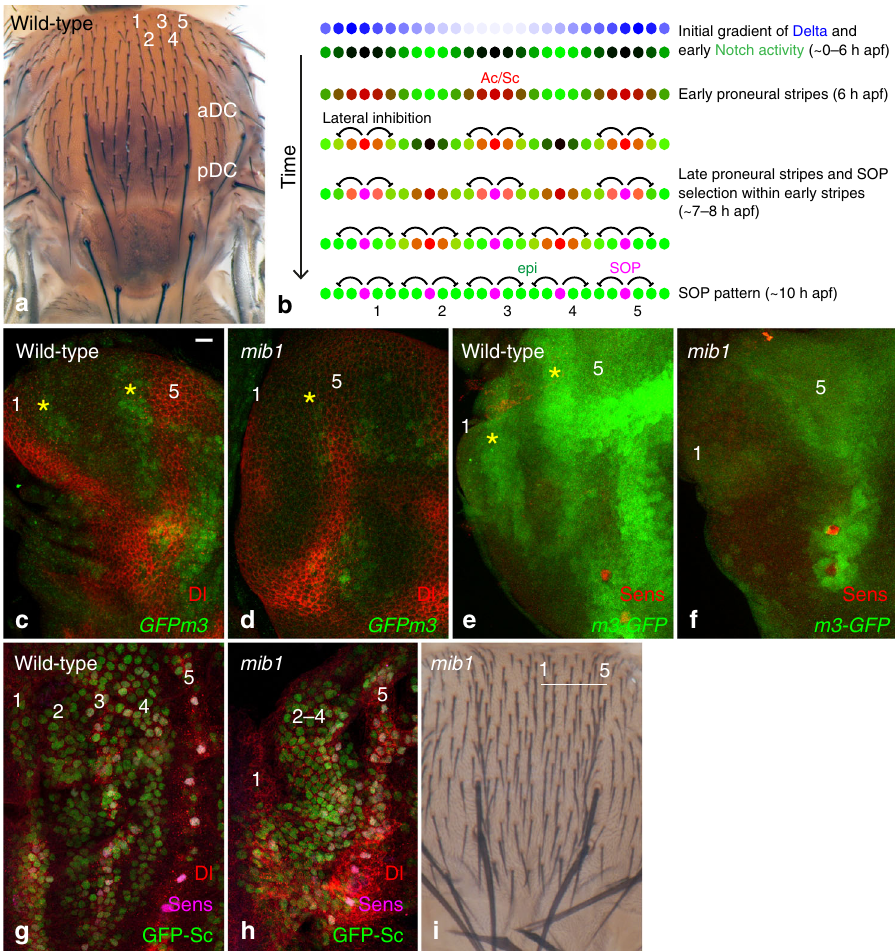
Fig. 1 mib1 -dependent Notch activity is required for stripe patterning. a A dorsal view of a wild-type adult fl y showing the fi ve regular rows of microchaetae (1 – 5) on each hemi-notum. The anterior and posterior DC macrochaetae (aDC and pDC) are located at the base of row 5. b Patterning dynamics in the notum 9 : downstream of a bimodal gradient of Dl, a proneural-independent pattern of Notch activity (green) determines the position of the fi rst proneural stripes (proneural activity, red). As the pattern of Notch activity evolves, two additional proneural stripes emerge and SOPs (magenta) are selected within each stripe. c , d GFPm3 (GFP, green) is expressed in two stripes of cells (yellow asterisks) fl anking cells expressing high levels of Dl (red; located at the position of the future stripes 1 and 5) in 2.5 h apf wild-type nota ( c ). The expression of GFPm3 is strongly reduced in mib1 mutant pupae ( d ). e , f A m3-GFP transcriptional reporter (GFP, green) is expressed at high levels in two stripes of cells (yellow asterisks) fl anking stripes 1 and 5 in 2.5 h apf wild-type nota ( e ). Expression of the m3-GFP transcriptional reporter is strongly reduced in mib1 mutant pupae f Sens, red, marks cells of the DC macrochaetae